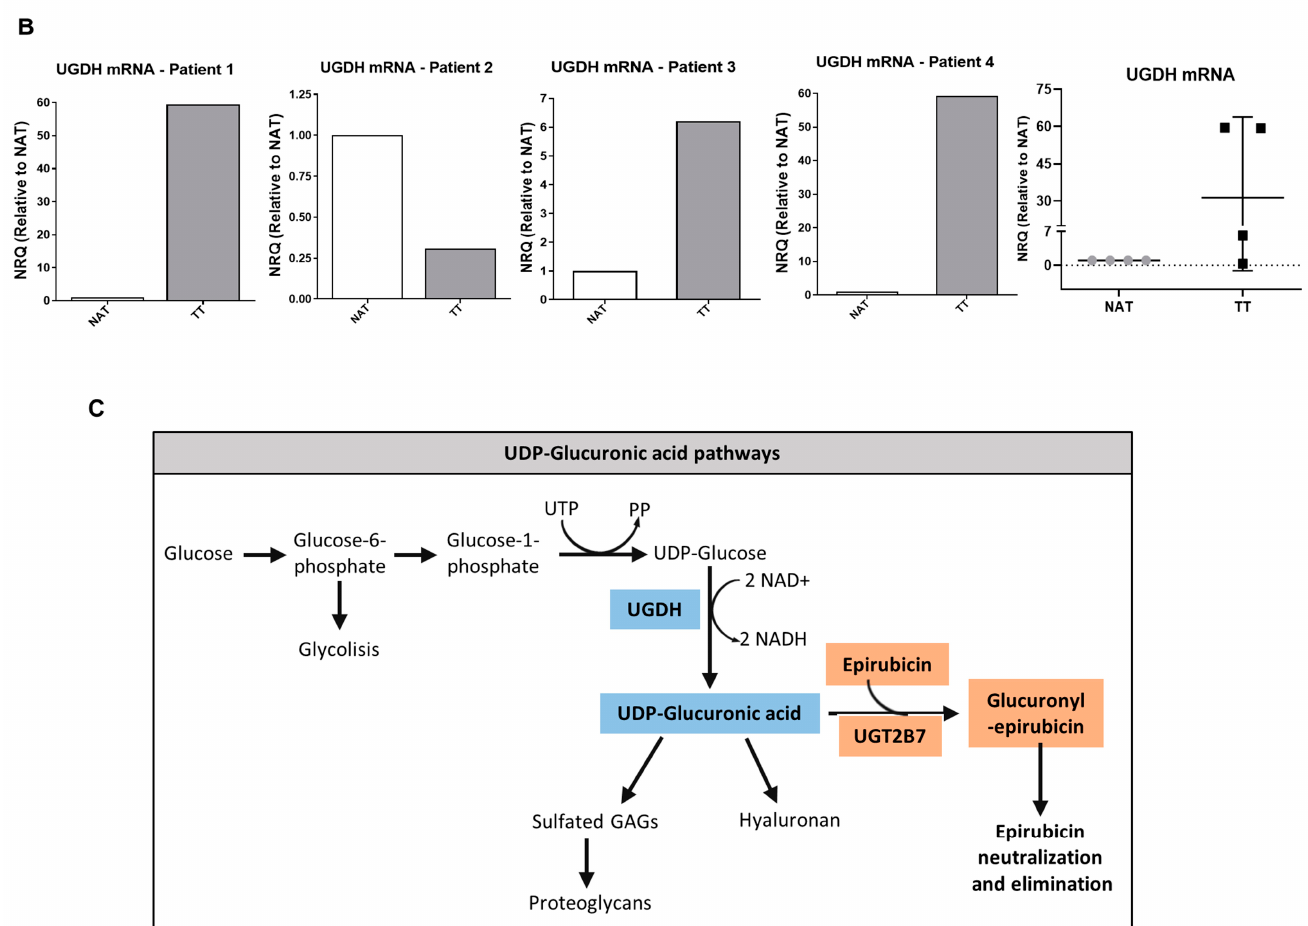
Figure 2. ( A , B ). Real-time PCR analysis of UGDH expression in patients with breast cancer. UGDH mRNA levels were normalized to housekeeping gene GAPDH and shown as tumor tissue (TT) relative to non-tumor tissue adjacent to tumor (NAT) of four different patients with breast cancer, characterized according to clinical parameters and ER, PR and HER2 status. ( C ). Schematic illustration of UDP-GlcUA pathways: GAG and PG synthesis, and role in EPI elimination.